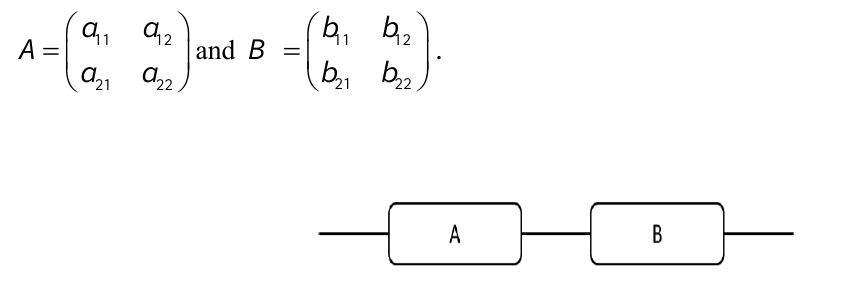
Fig. 6. RBD of components A and B in series